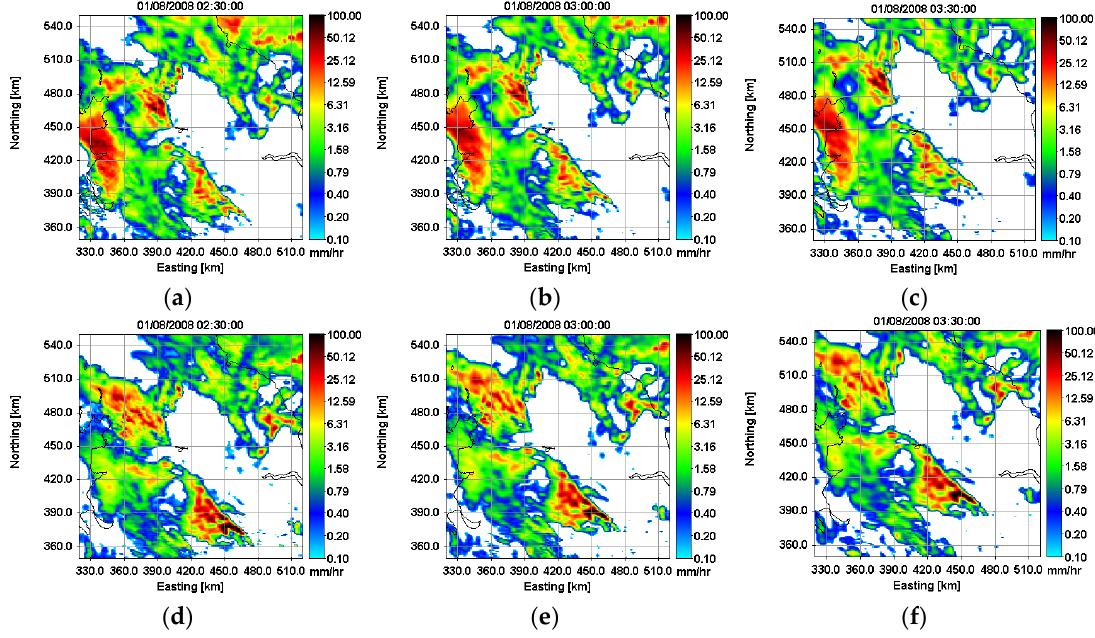
Figure 3. Radar ensemble forecasts at time t = 30 min ( a , d ), t = 60 min ( b , e ), t = 90 min ( c , f ) starting on 1 August 2008 at 02:00.